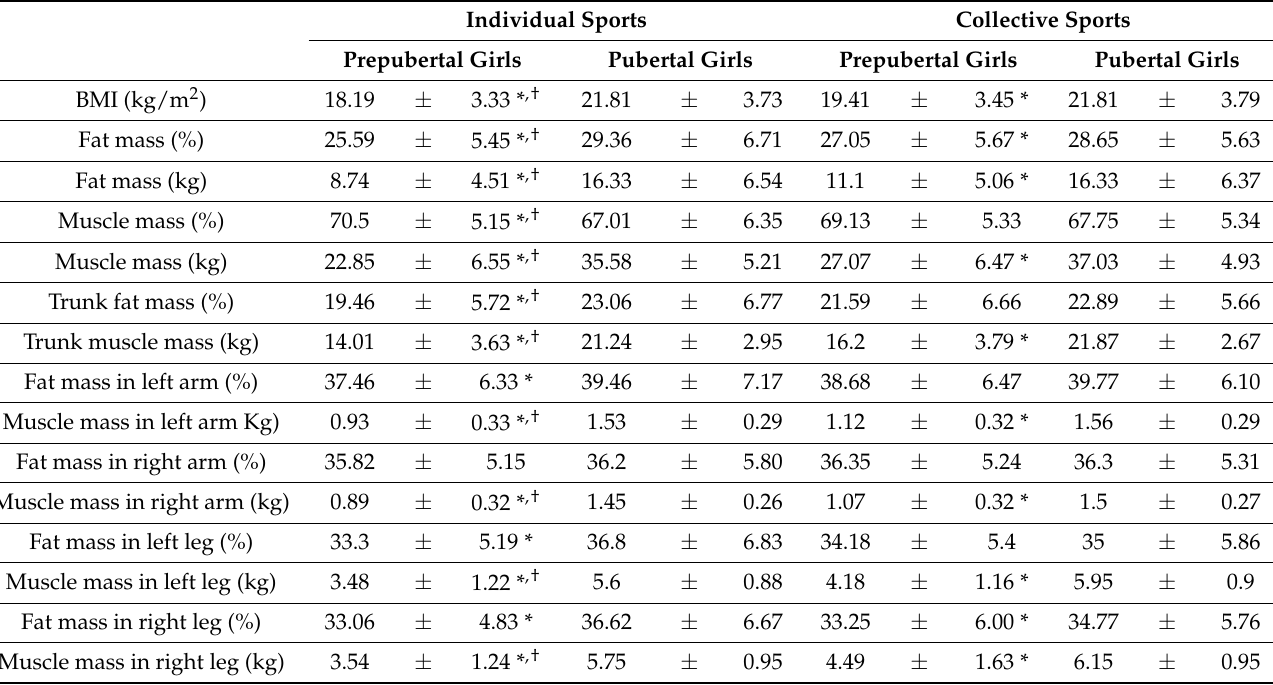
Table 1. Body composition variables according to the typology of sport in prepubertal and pubertal girls.